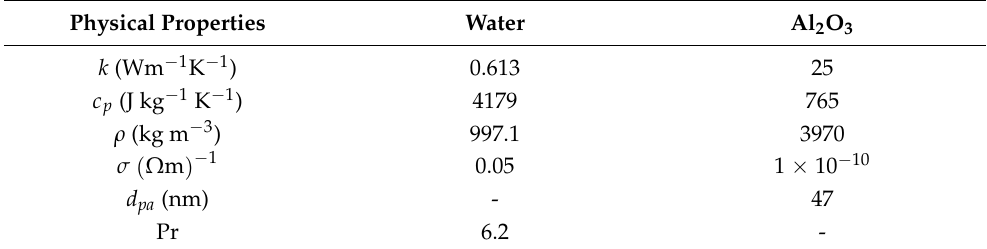
Table 1. Thermophysical properties of the